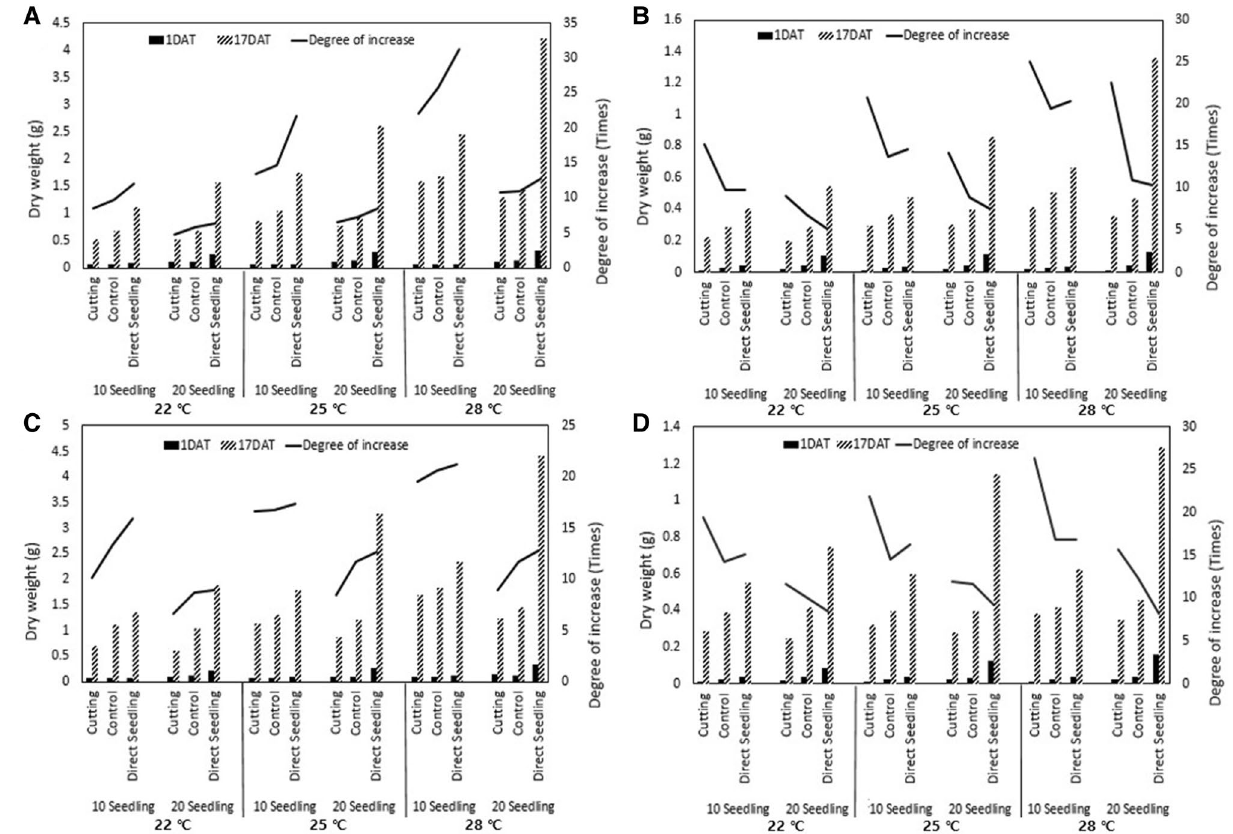
Figure 4. The dry weights of rice shoots and roots on days 1 and 17 after transplantation (left axis), and degree of dry weight increase (right axis). ( A ) Odae, shoot; ( B ) Odae, root; ( C ) Saenuri, shoot; ( D ) Saenuri,